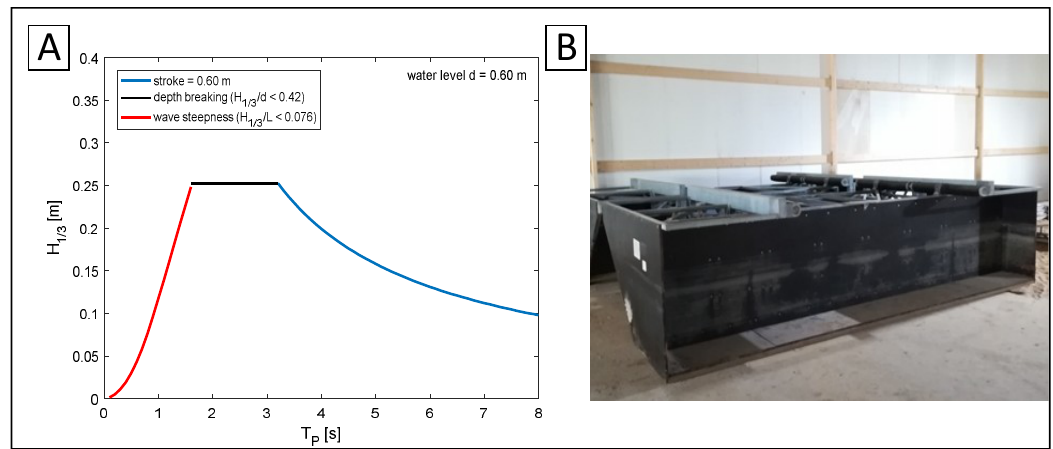
Figure 3. ( A ) Wave parameters for OWB (theoretical values, 90% practical reachable) and ( B ) Two DHI piston type wave paddle elements with a maximum width of 7 m and height of 1 m.